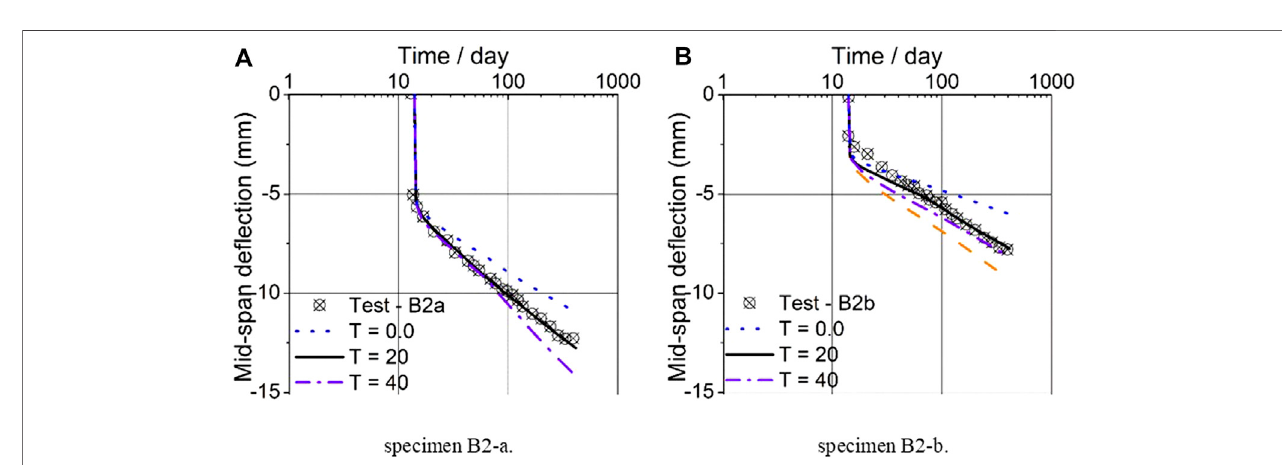
FIGURE 11 | Mid-span de fl ection curves at various